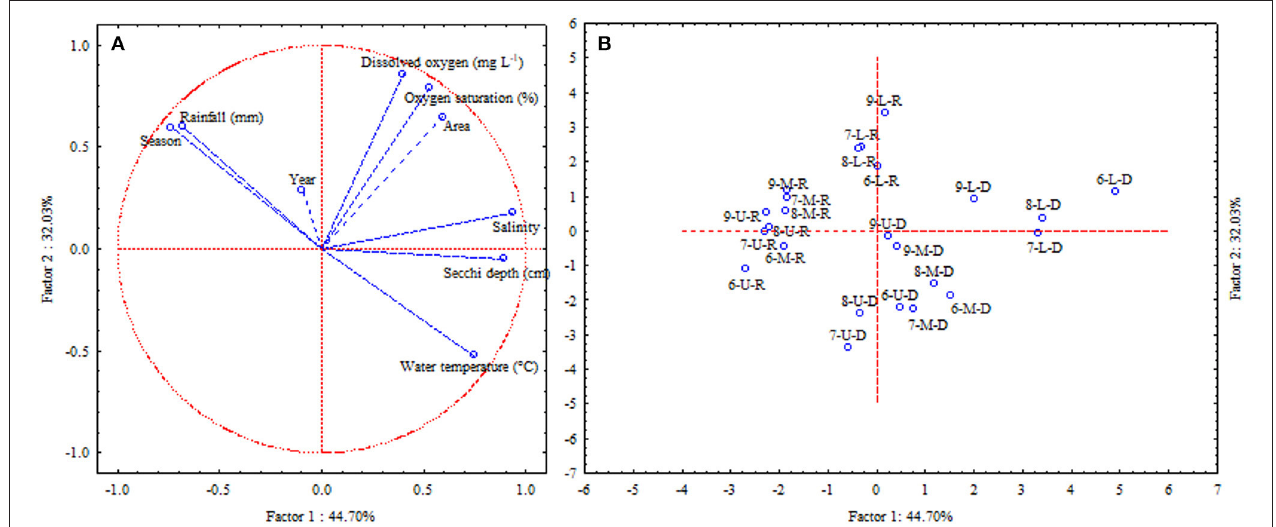
FIGURE 9 | (A) Weight graph (PCA) showing the contribution of environmental variables to the water quality patterns at the Goiana River estuary from 2006 to 2009. (B) Score graph (PCA) showing the contribution of environmental variables to the water quality patterns at the Goiana River estuary from 2006 to 2009. Legend for samples: first numeral represents the year (6 - 2006, 7 - 2007, 8 - 2008, 9 - 2009); second letter represents estuarine area (U, upper; M, middle; L, lower) and third letter represents season (D, dry; R, rainy).